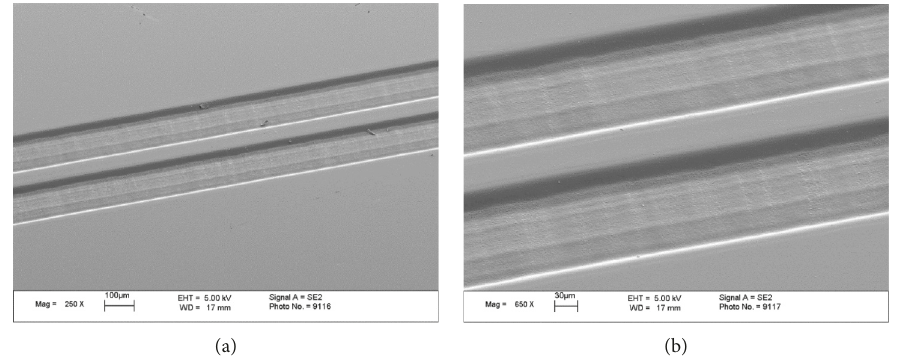
Figure 5: SEM images of ablated depth at (a) 250x and (b) 650x magnifications (sample number 61: number of shots fluence 0.1J/cm 2 , scanning speed 3.3 mm/min, and pulse repetition rate (cid:31) (cid:31) and 0.740 μ m,